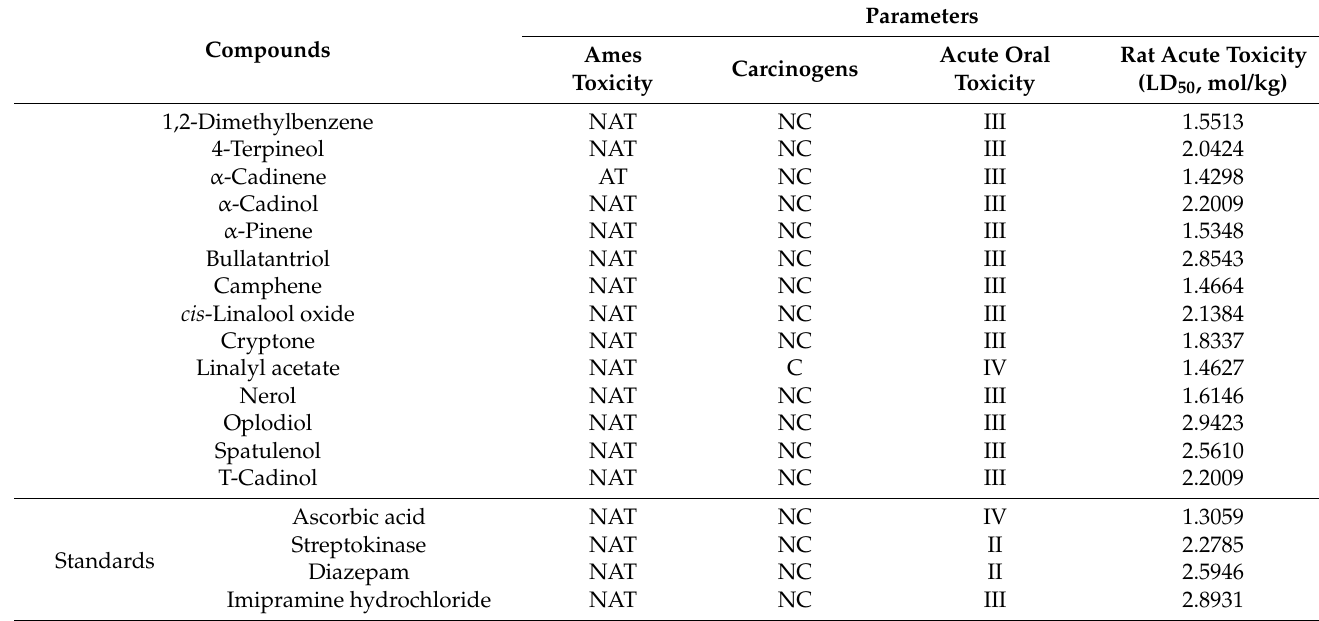
Table 7. Toxicological properties of the phytochemical compounds of essential oil in leaves of H. aromatica.